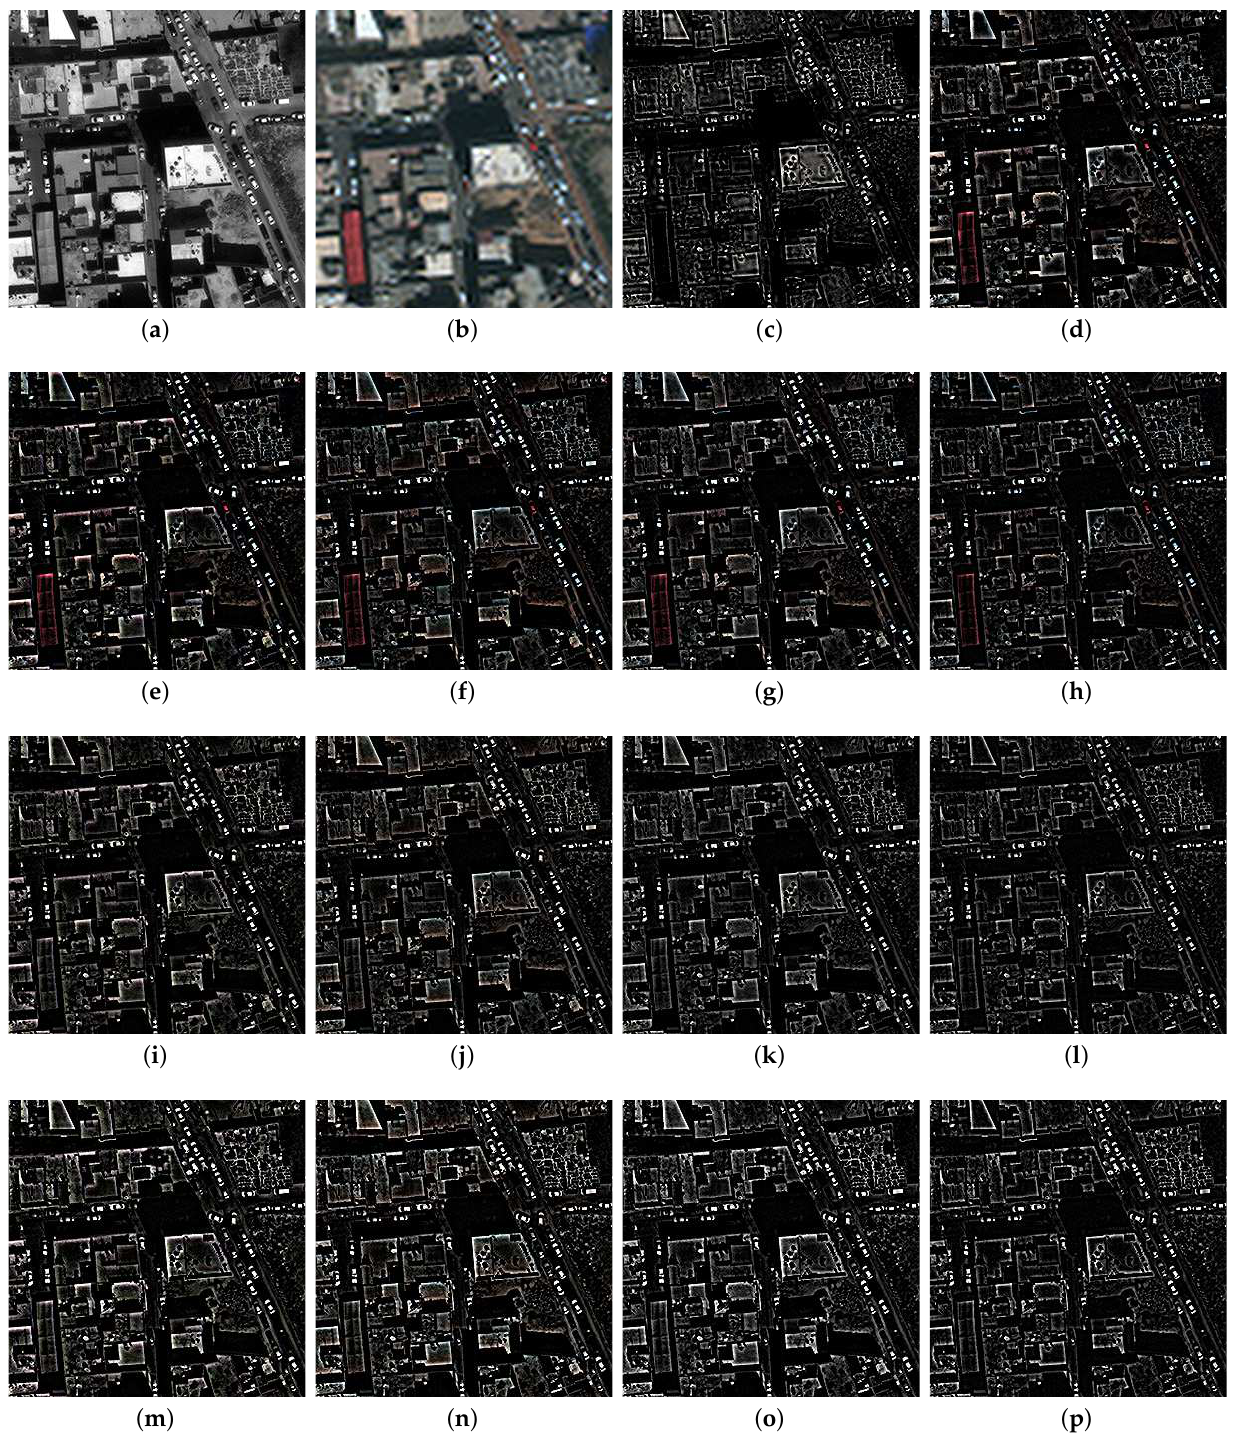
Figure 7. Close-ups of the details of the fused results using the full resolution Tripoli dataset: ( a ) PAN; ( b ) EXP; ( c ) details for GSA; ( d ) details for MF-HG; ( e ) details for MBFE-BDSD-HPM; ( f ) details for MBFE-GSA-HPM; ( g ) details for FE-HPM; ( h ) details for GLP-HPM; ( i ) details for MBFE-BDSD-CBD; ( j ) details for MBFE-GSA-CBD; ( k ) details for FE-CBD; ( l ) details for GLP-CBD; ( m ) details for MBFE-BDSD-MLR; ( n ) details for MBFE-GSA-MLR; ( o ) details for FE-MLR; ( p ) details for